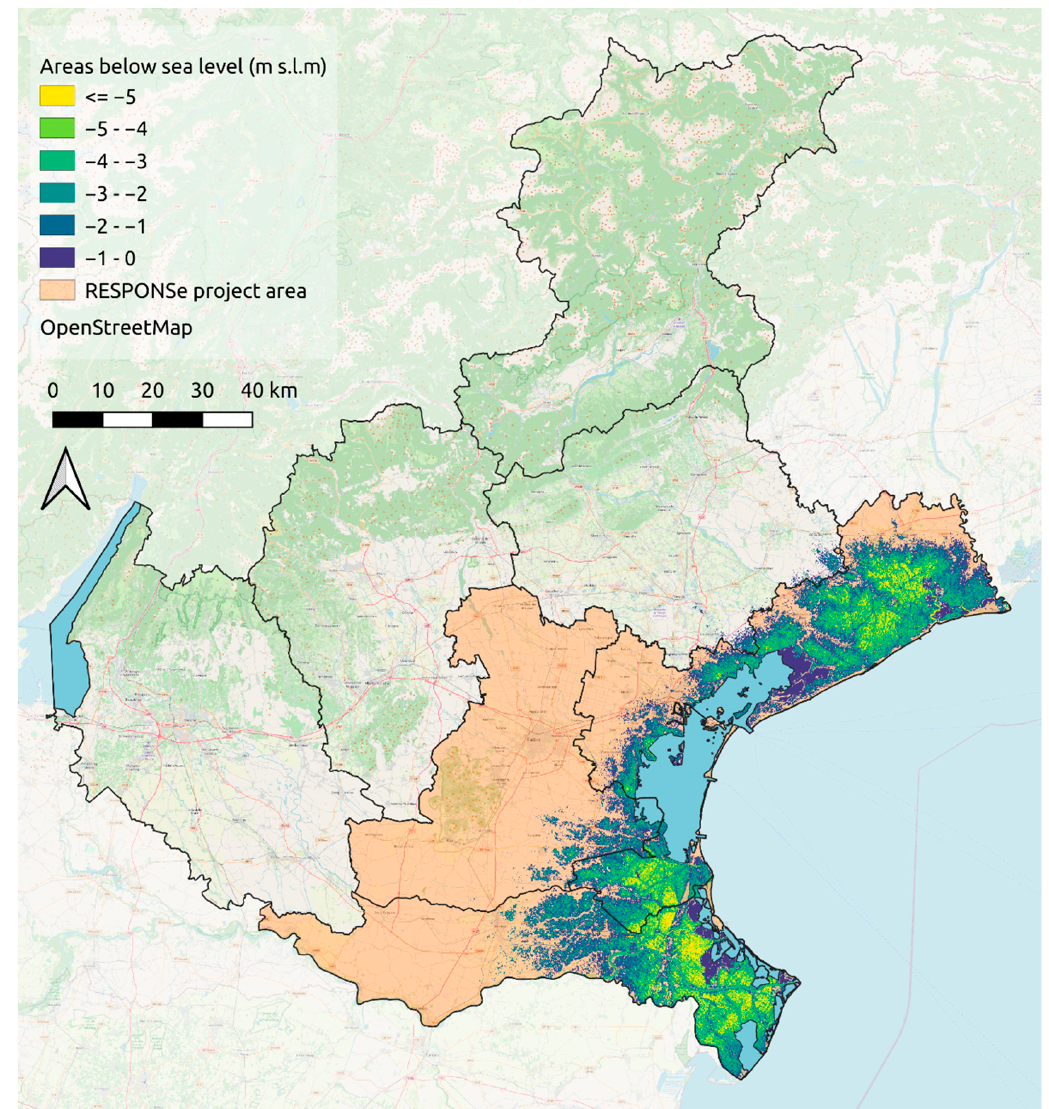
Figure 1. The Veneto Region with provincial borders and highlighted in orange the provinces that are eligible areas of the RESPONSe project. The other colored areas identify the portions of the plain below sea level.